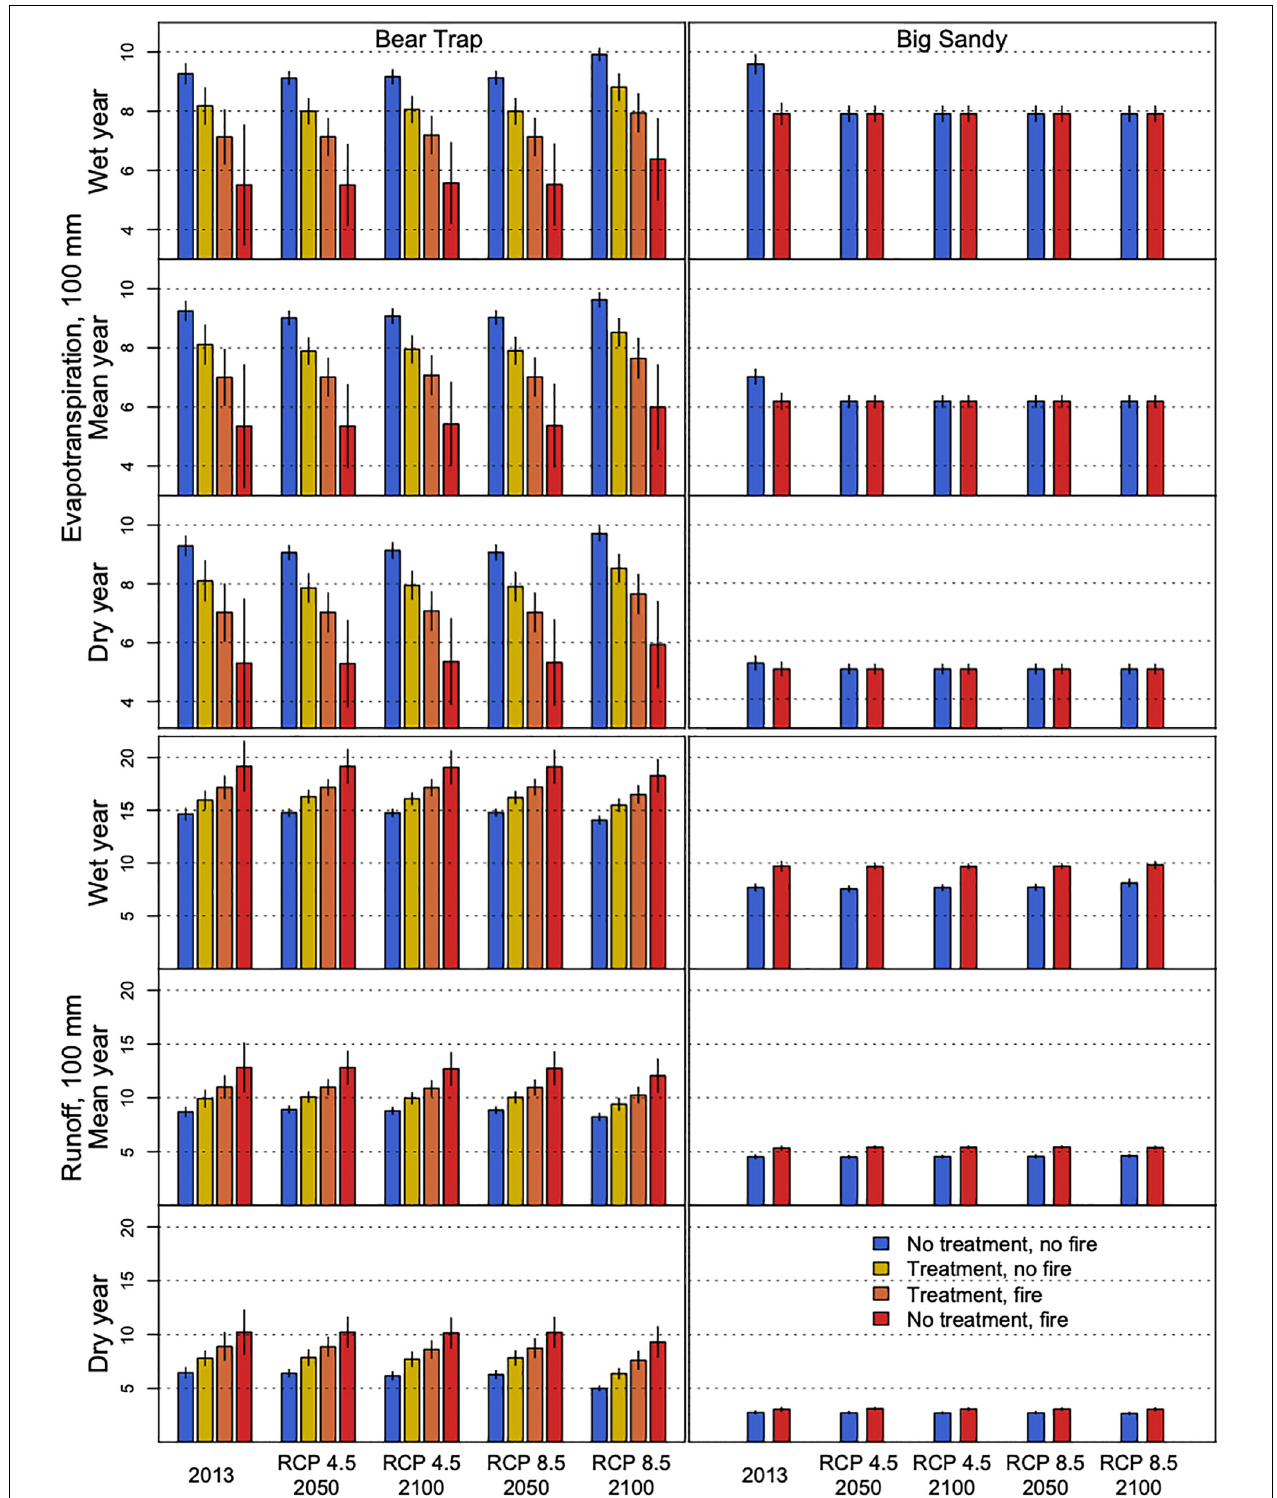
FIGURE 4 | Evapotranspiration (upper 6 panels) and runoff (lower 6 panels) for forest-treatment and disturbance scenarios during dry (2012), mean (all years), and wet (2011) precipitation conditions for current and projected temperatures Vertical bars indicate the 95% confidence interval based on the multiple parameter sets for each catchment. Left column of panels is Bear Trap and right column of panels is Big Sandy. Big Sandy mean basin LAI following treatments were not different than having no treatment and are not shown.